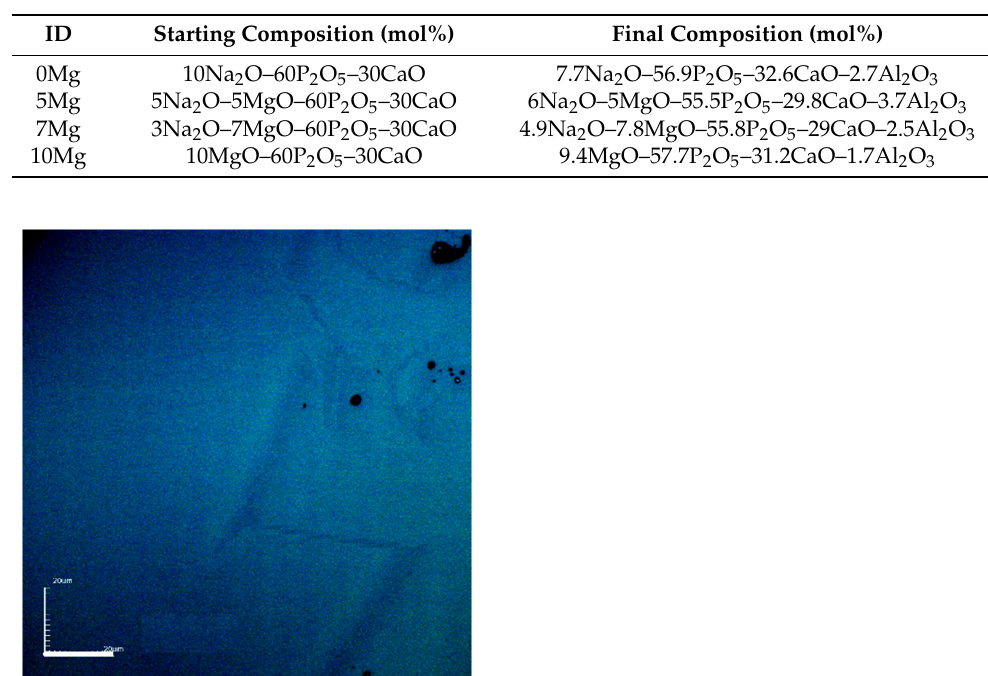
Table 1. IDs, starting and final compositions of all samples.